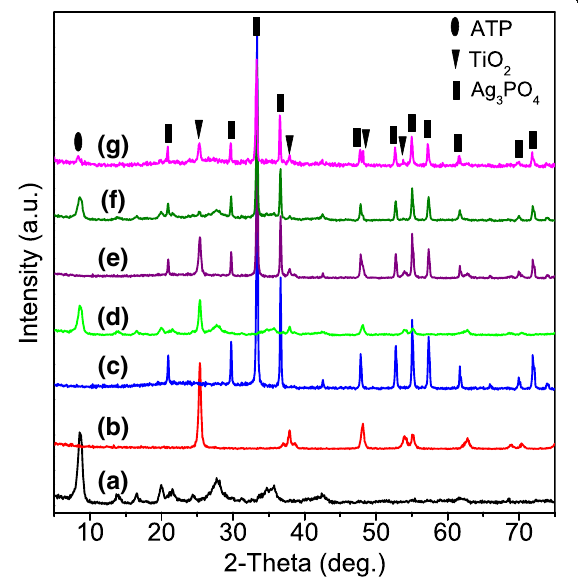
Fig. 1 XRD patterns of samples: a ATP, b TiO 2 , c Ag 3 PO 4 , d ATP/TiO 2 , e Ag 3 PO 4 /TiO 2 , f ATP/Ag 3 PO 4 , and g ATP/TiO 2 /Ag 3 PO